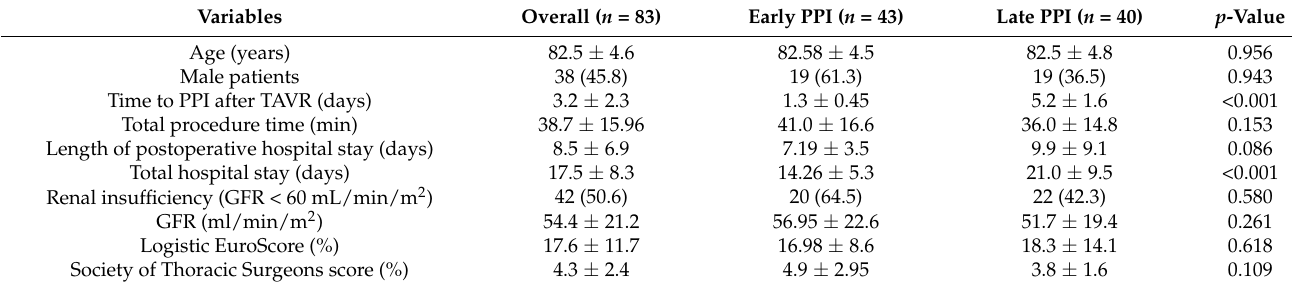
Table 3. Comparison of clinical parameters in patients with respect to PPI timing (48 h vs. later).